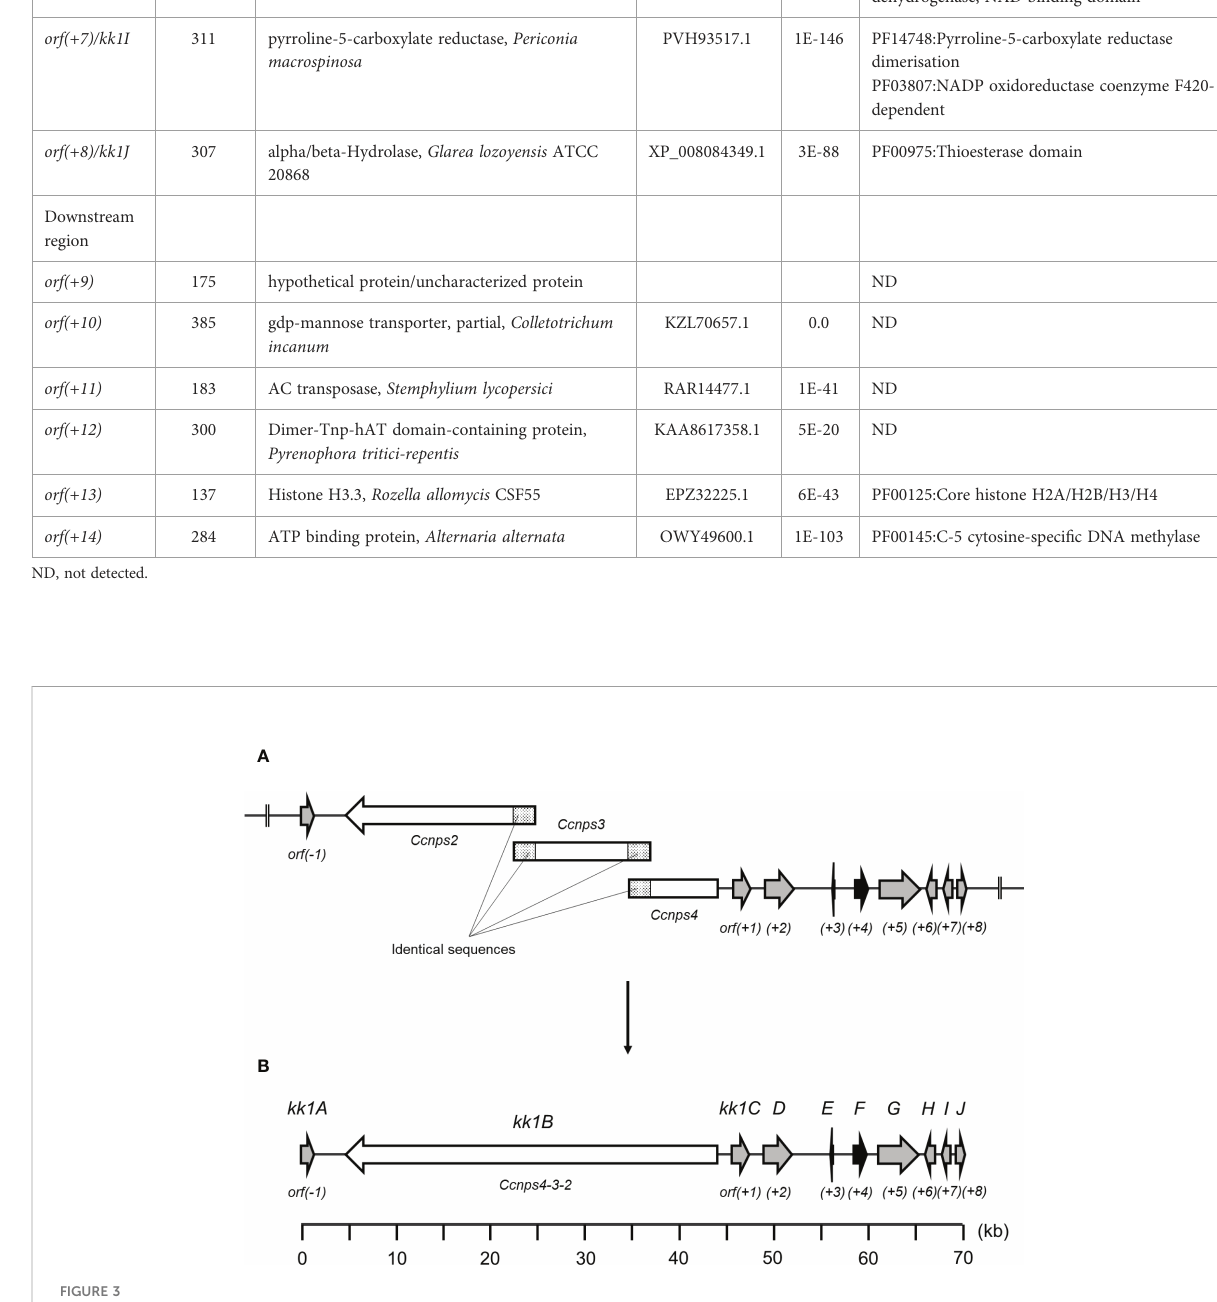
gene kk1B , encoding non-ribosomal peptide synthetase (NRPS), is shown as a white arrow, and kk1F , encoding the transcription factor, is shown as a black